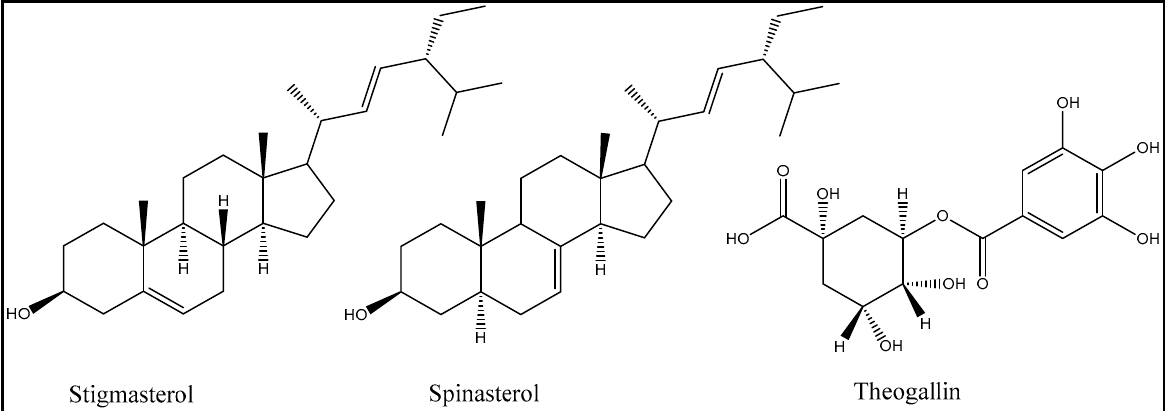
Figure 2. The major secondary metabolites identified in the acetone extracts of Acacia ehrenbergiana. Table 4. The antibacterial activity of the metabolites identified in the acetone extracts of Acacia ehrenbergiana . Isolated Compound Organism